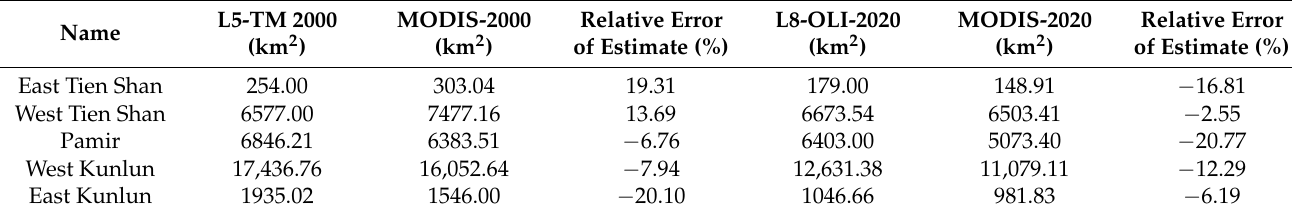
Table 2. Estimated area of five subregions: L5-TM 2000 vs. MODIS 2000 and L8-OLI 2020 vs. MODIS 2020; relative error was calculated by applying L5-TM 2000 and L8-OLI 2020 as reference,